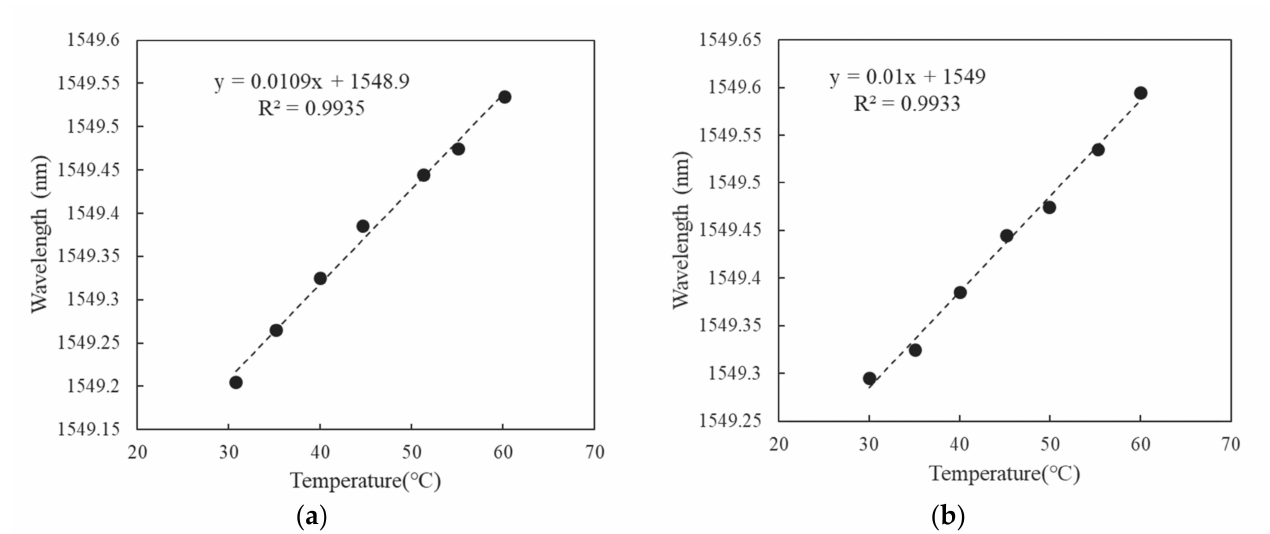
Figure 4. Wavelength and temperature curve. ( a ) Test result of the first set. ( b ) Test result of the second